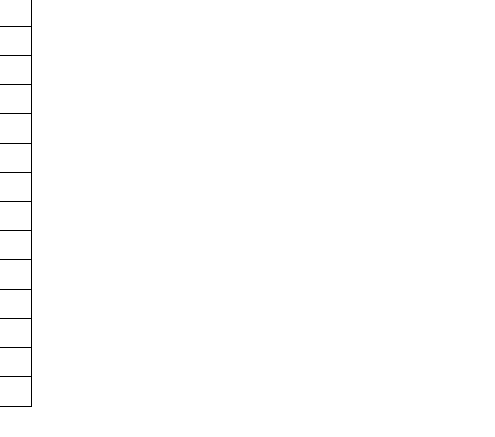
Table 3. Streptomyces strains used for